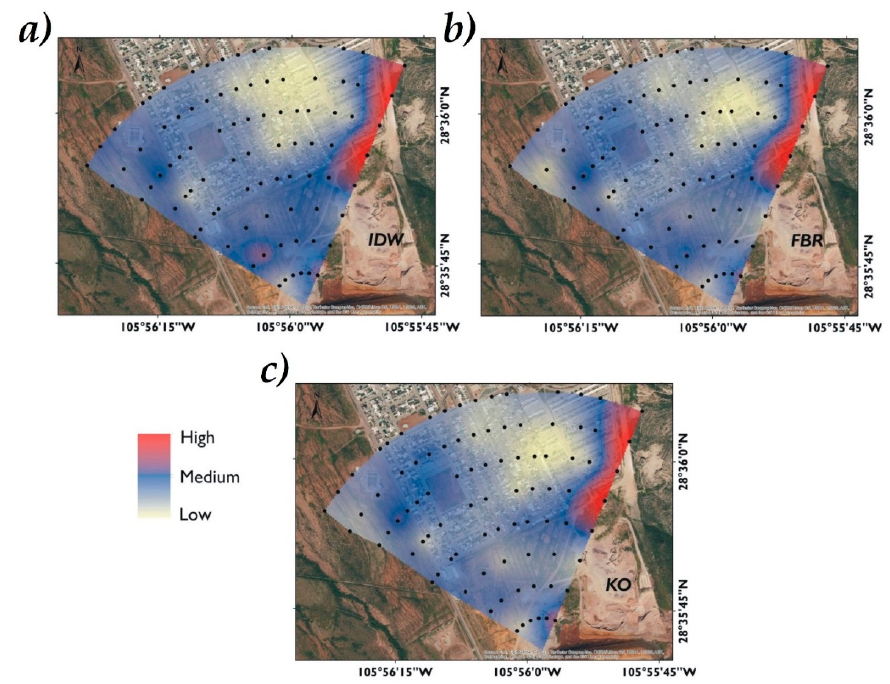
Figure 11. Error maps in P2 between experimental values and those estimated by interpolation models. IDW ( a ), RBF ( b ), and OK ( c ). Samples ( ● ), errors between the experimental values and estimated values: high ( ■ ), medium ( ■ ), low ( ■ ).